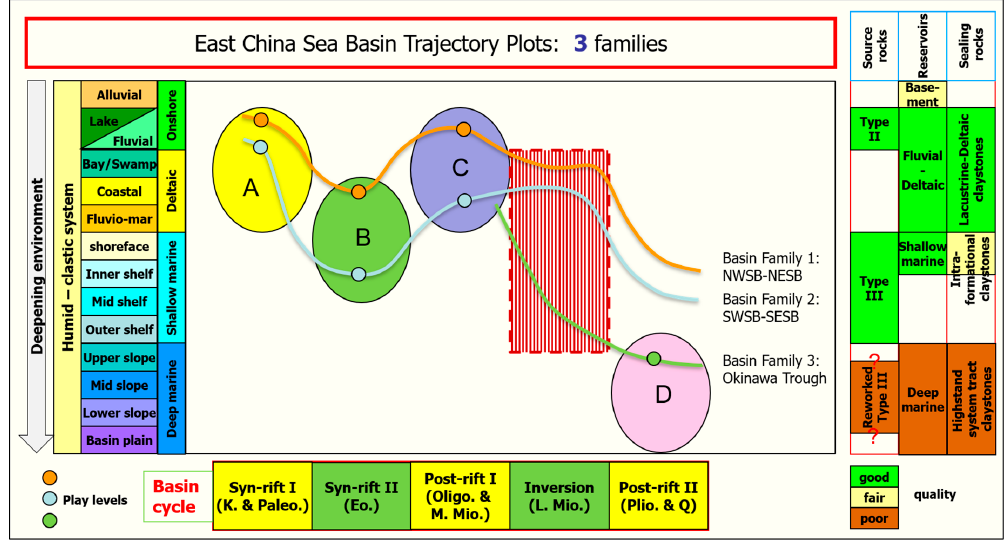
Figure 16. Petroleum system types in the East China Sea Basin showing the depositional environment evolution in relation to tectonic basin stages. The tectono-stratigraphic situation of PSTs is indicated by colored ovals: A (yellow) = PST A; B (green) = PST B; C (mauve) = PST C and D; (pink) = PST D. NWSB = Northwest Shelf Basin; NESB = Northeast Shelf Basin; SWSB = Southwest Shelf Basin; SESB = Southeast Shelf Basin. The red dashed area shows the inversion cycle, which is largely an unconformity and a depositional hiatus.